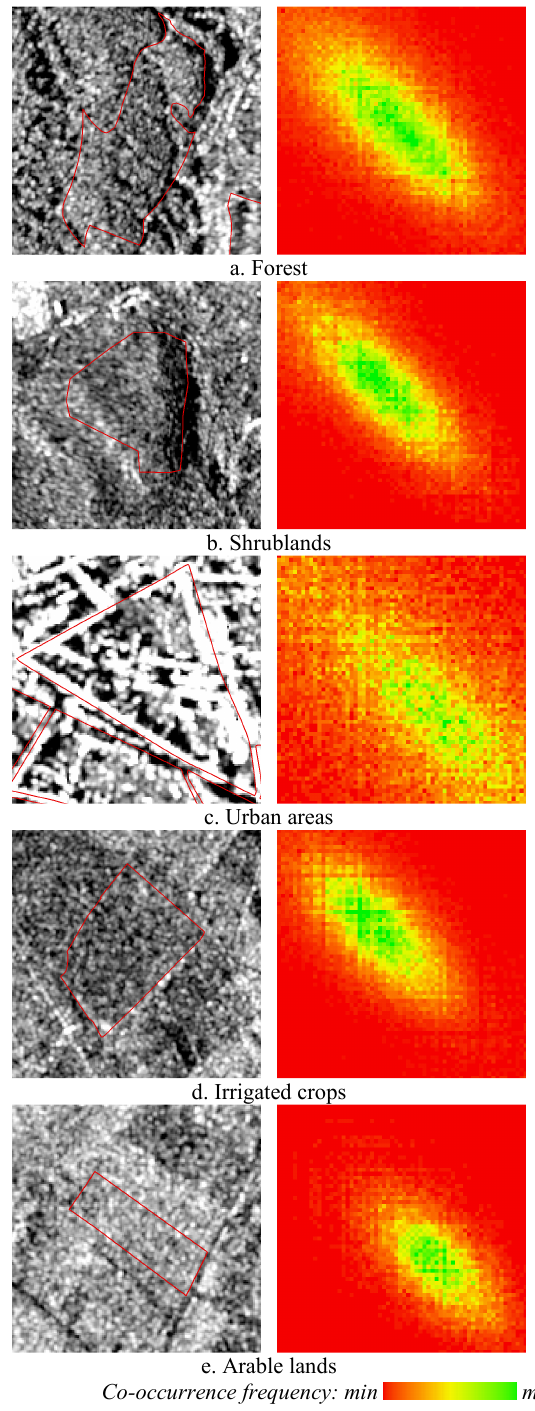
Figure 2. Examples of parcels of the defined classes in TerraSAR-X (left) and their graphic representation of the GLCM computed per-object